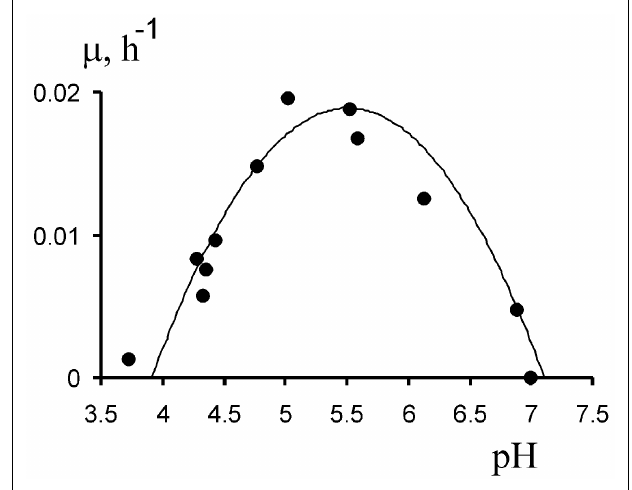
FIGURE 4 | Influence of medium pH on the growth of strain SP2 T